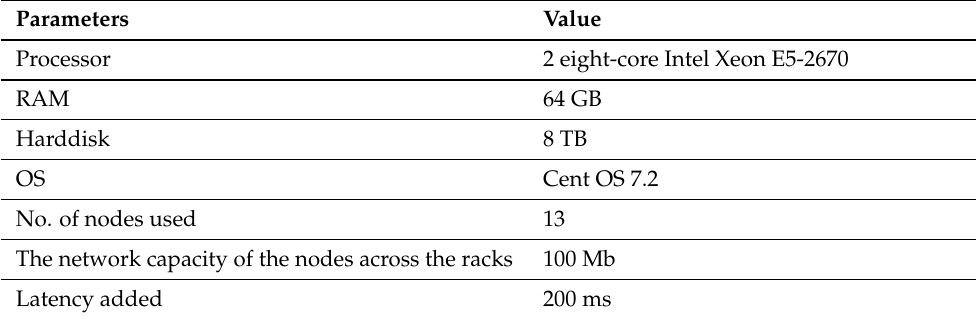
Table 12. Simulation parameter